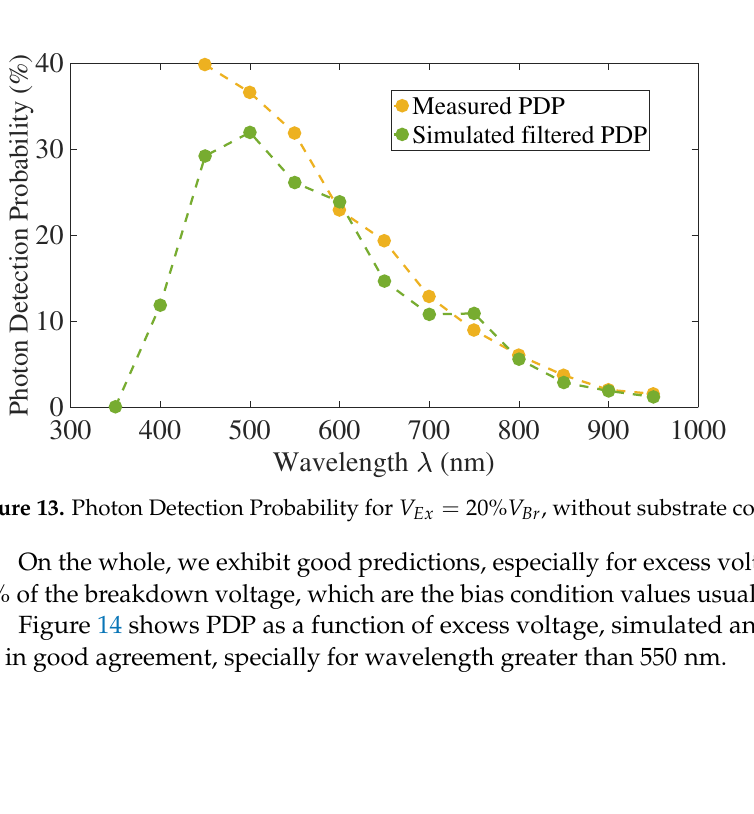
Figure 12. Photon Detection Probability and internal Quantum Efficiency for V Ex = 20% V Br , without substrate contribution.